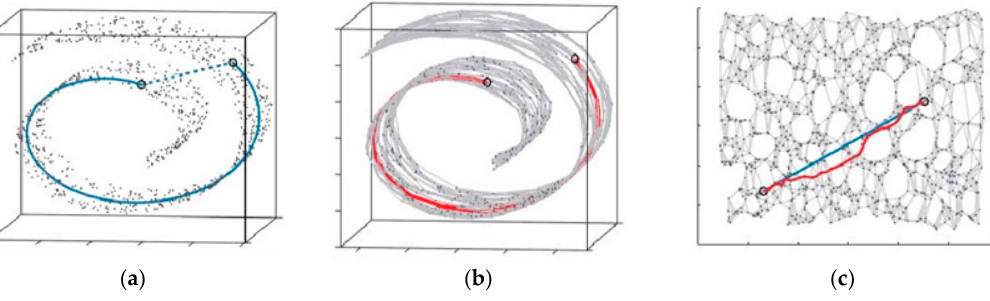
Figure 12. The geodesic distance in Swiss Roll. ( a ) real geodesic distance of the two samples; ( b ) approximate geodesic distance of the two samples; ( c ) comparison between the real geometric distance and the approximate geometric distance.